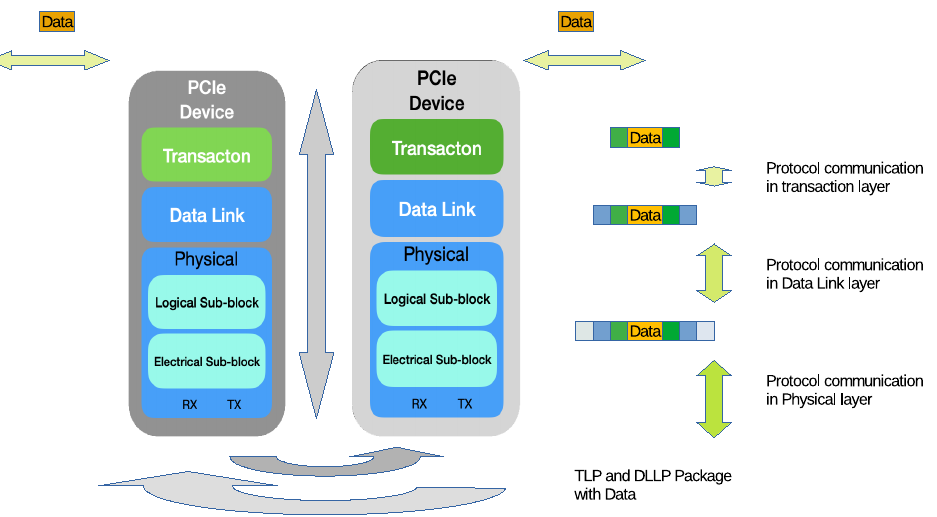
Figure 4. PCIe layers